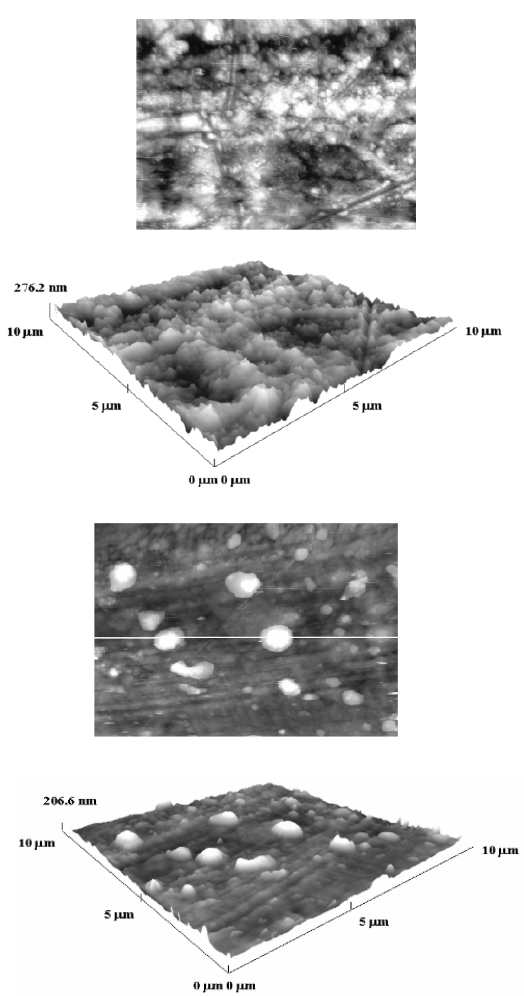
Figure 17. AFM top view of copper chalcogenide layers on PA